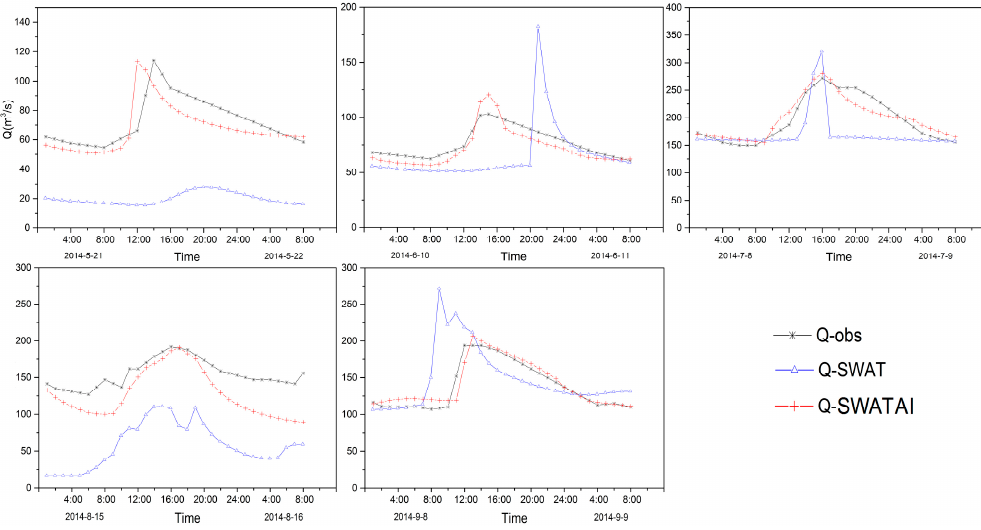
Figure 5. Hourly simulation results during the validation period (2014).